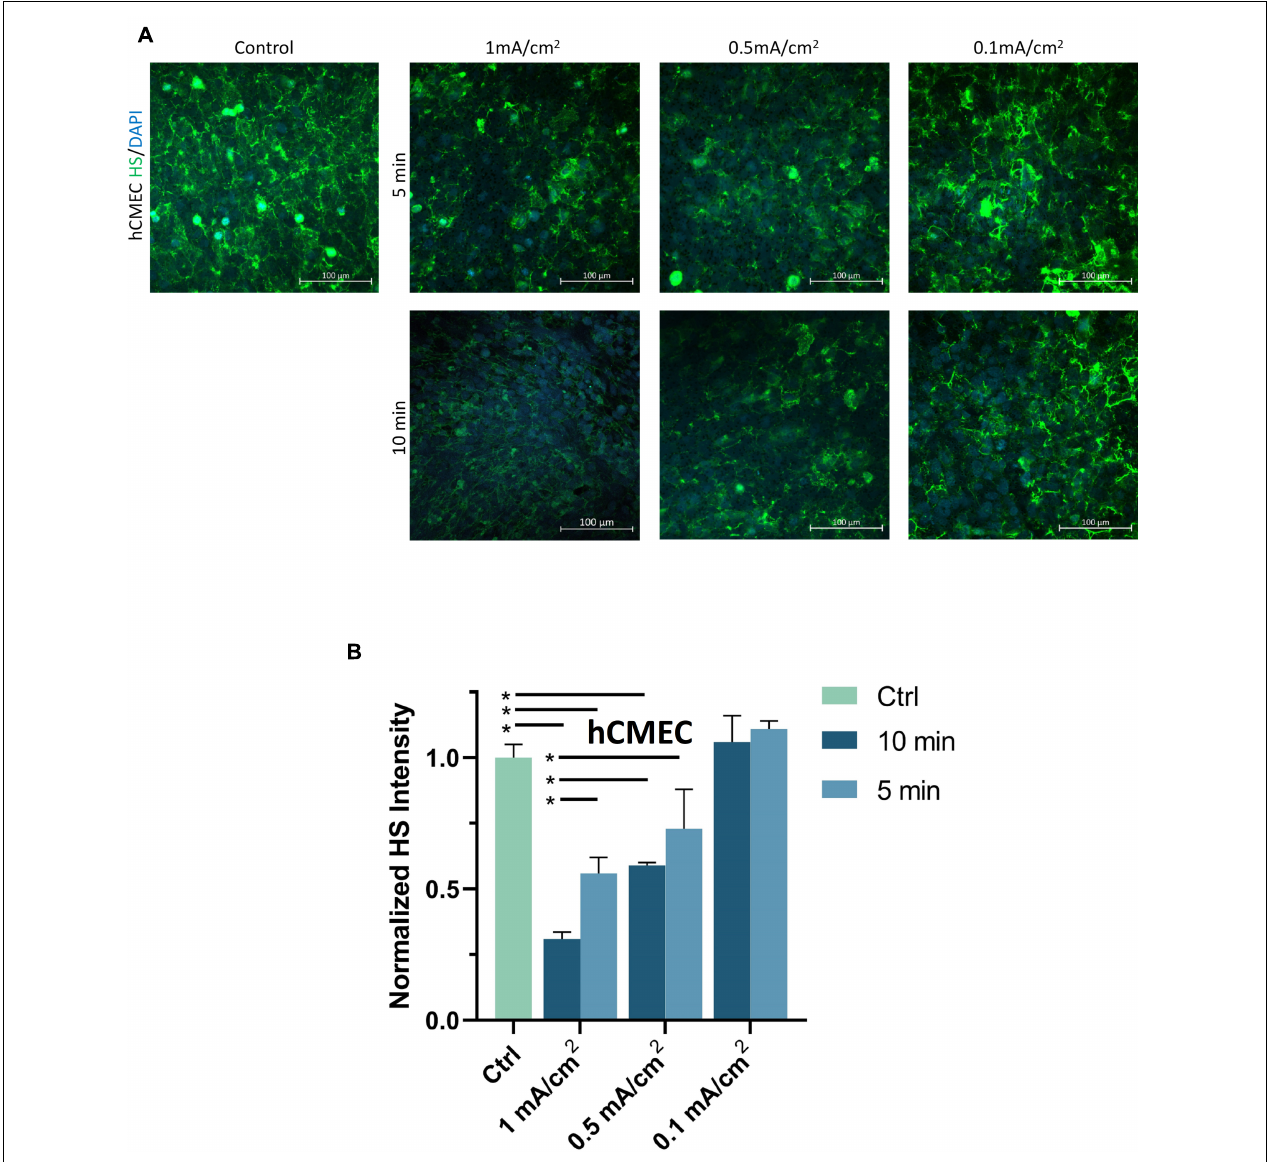
FIGURE 4 | Effects of DCS strength on HS of endothelial glycocalyx (EG) of in vitro BBB formed by hCMEC monolayer. (A) Confocal images of heparan sulfate (HS) of EG on in vitro BBB and (B) comparison of HS intensity under control and after 5 min or 10 min treatments with 0.1, 0.5, or 1 mA/cm 2 DCS. * p < 0.05.